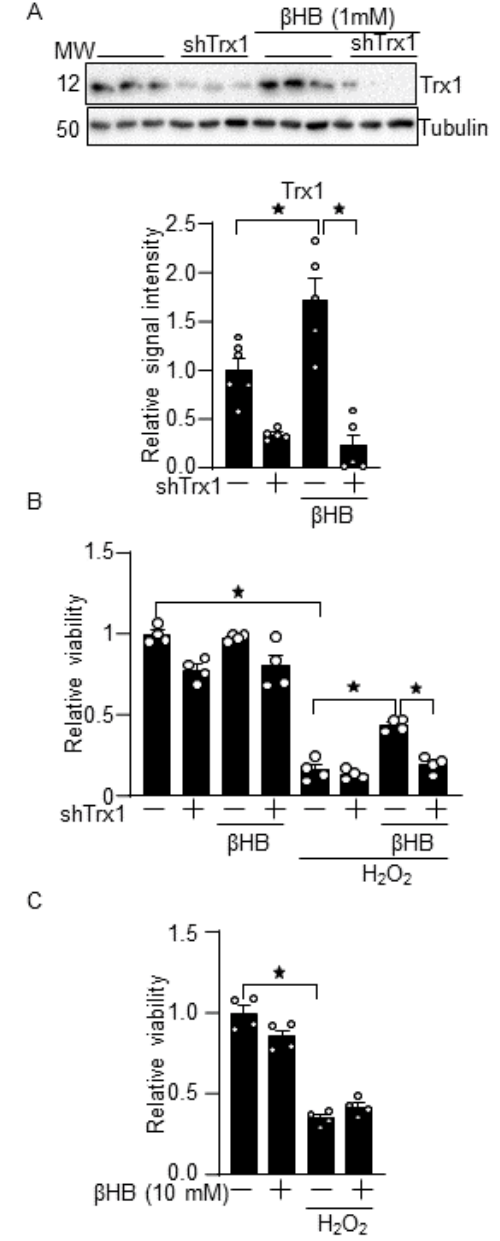
Figure 2. βHB potentiates the antioxidant defense in a Trx1-dependent manner. ( A ) Trx1 knockdown inhibits βHB-induced Trx1 upregulation. Cardiomyocytes were treated with Trx1 short hairpin RNA (shTrx1) adenovirus vector for 3 days and with 1 mM βHB for 16 h. The expression of Trx1 was examined using Western blot analysis. n = 5–6. ( B ) βHB inhibits H 2 O 2 -induced cardiomyocyte death in a Trx1-dependent manner. ( C ) A high dose of βHB (10 mM) did not significantly inhibit H 2 O 2 -induced cardiomyocyte death. ( B – C ) Cardiomyocytes were treated with 1 or 10 mM βHB for 16 h and were then treated with 100 µM H 2 O 2 for 6 h. The cardiomyocyte viability was examined using trypan blue dye exclusion. n = 4. * p < 0.05 ( A – C ).